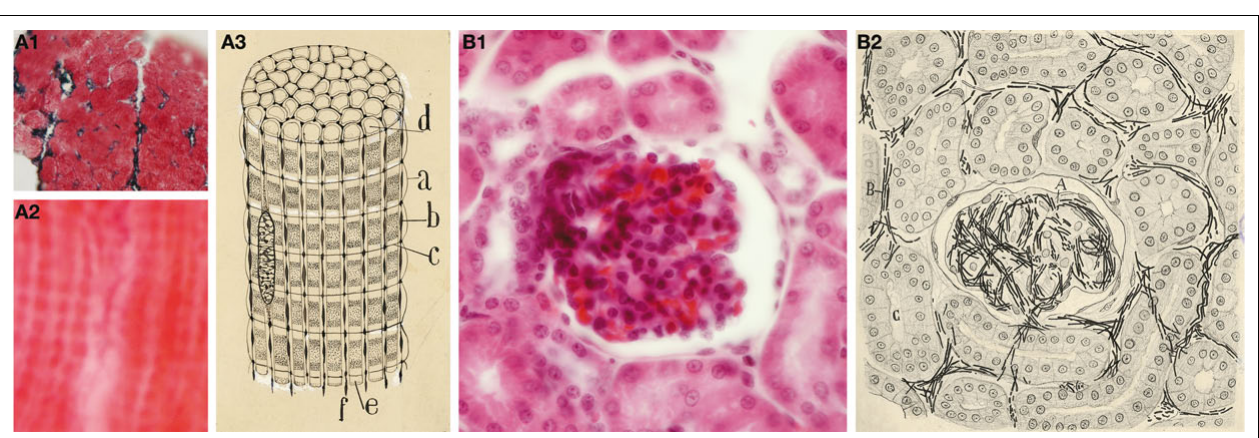
FIGURE 9 | Cajal’s general histological preparations and drawings. (A) Muscle fi ber, gold chloride; (B) Kidney, hematoxilyn and eosin (Drawings reproduced with the permission of Inheritors of Santiago Ramón y Cajal